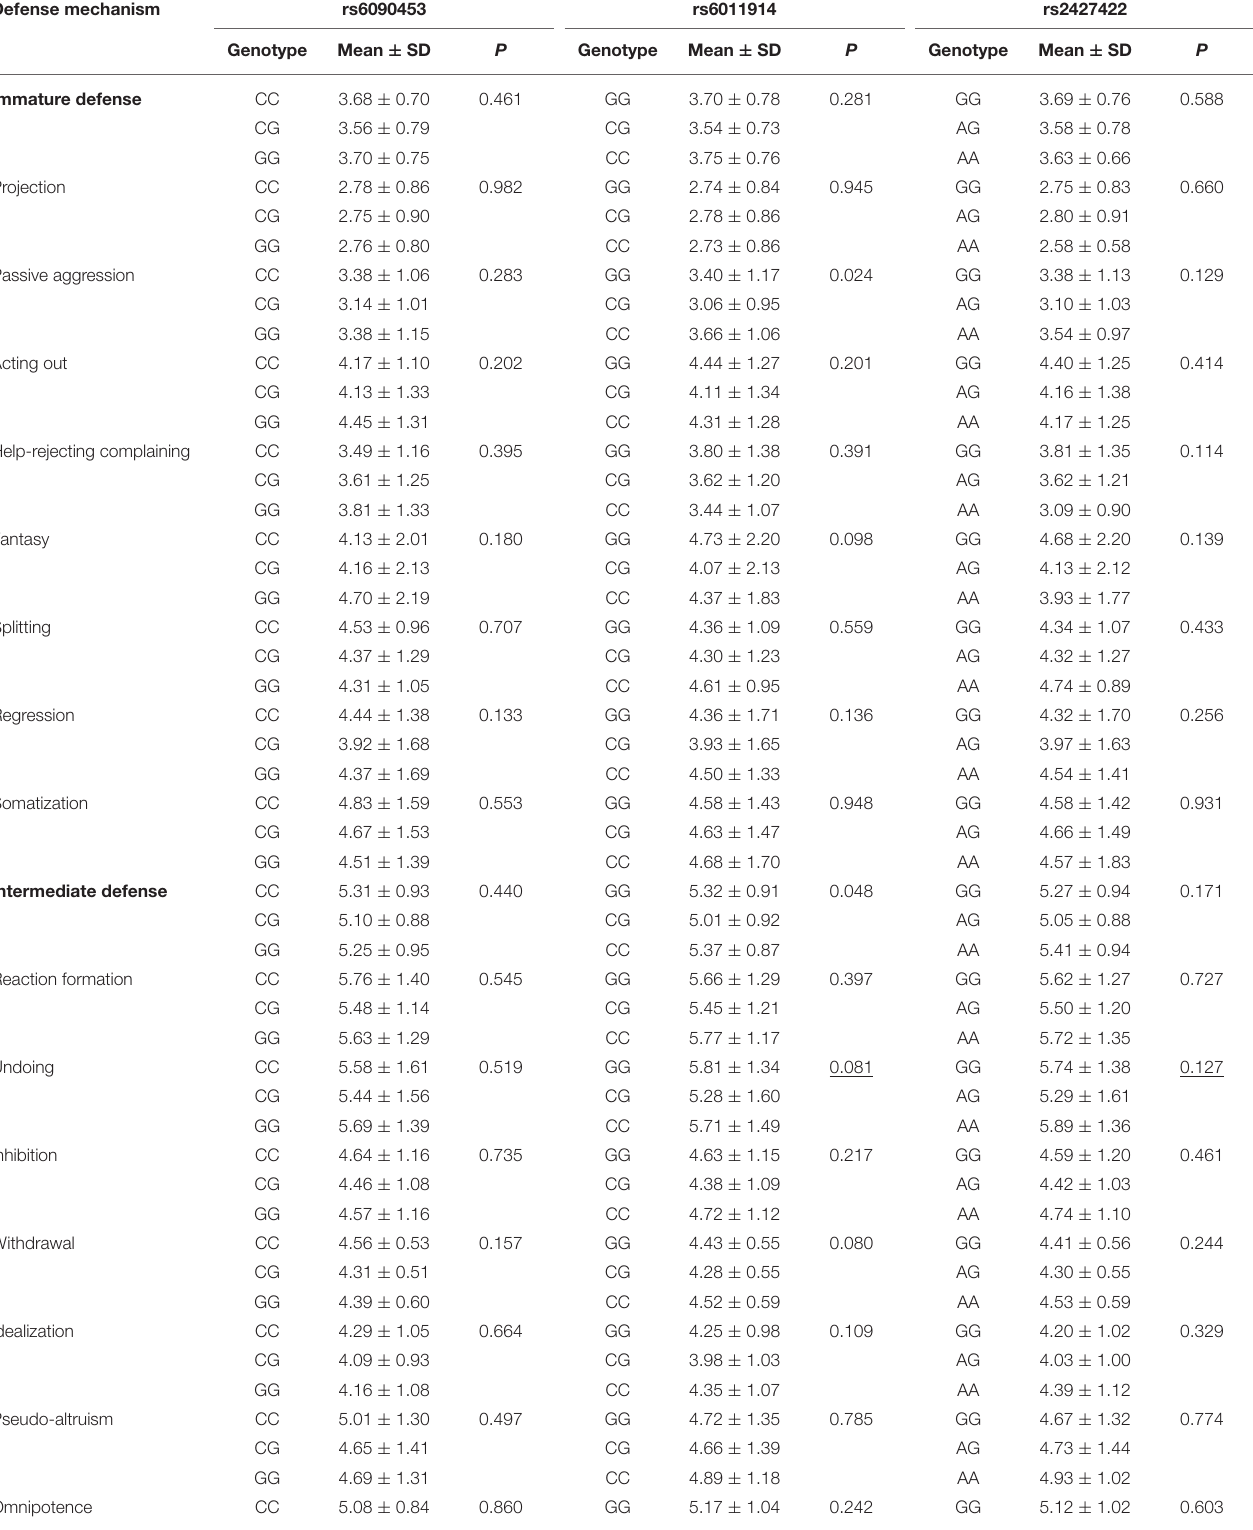
TABLE 4 | Effects of NTR1 gene polymorphisms on DSQ scores in